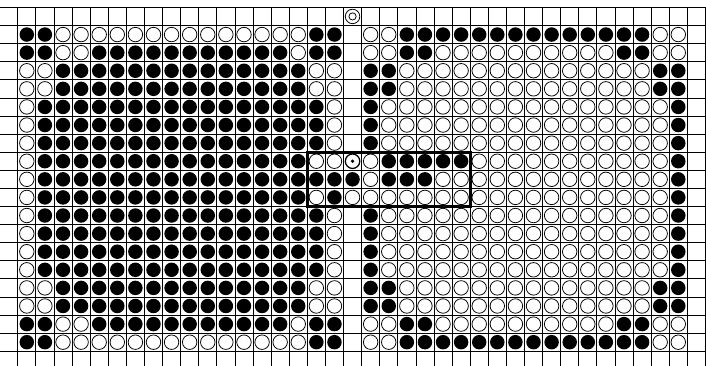
Figure 40. B-weak point with a focus.